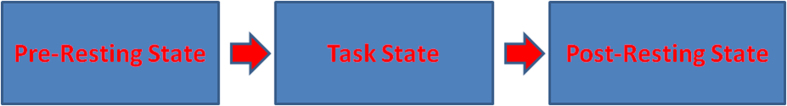
Experimental design.Task design order: pre-resting state, attention task, and post-resting state. For both resting-state conditions, participants were instructed to lie still, relax, and close their eyes. During the cognitive task condition, participants performed a visual attention task.